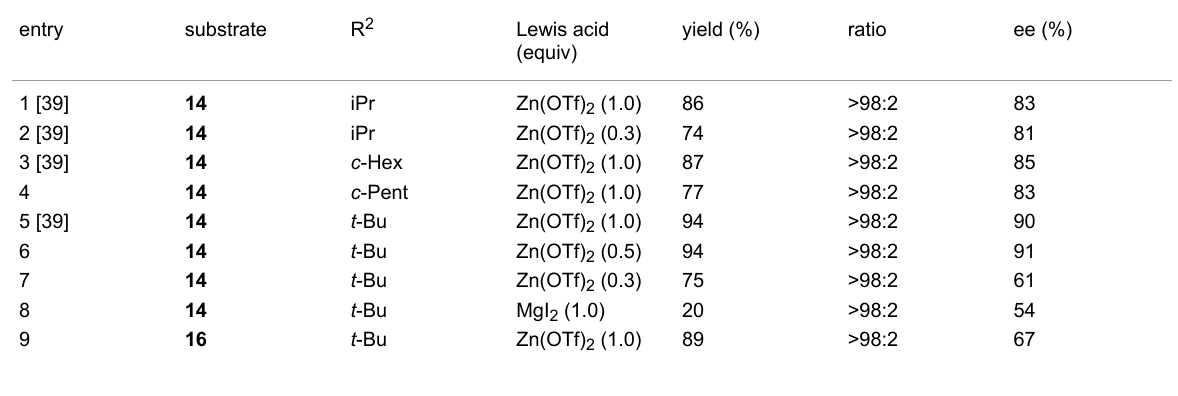
Table 2: Reaction of 14 and 16 in the presence of a chiral ligand.